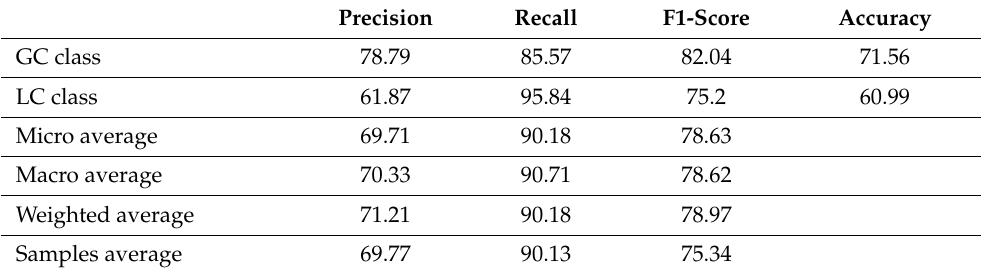
Table 3. Classification report of rule-based classifier.